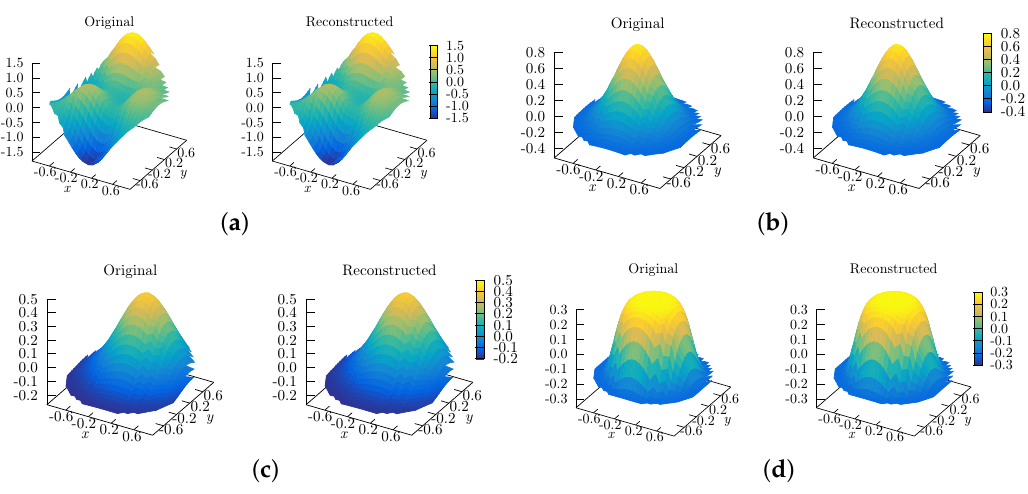
Figure 5. Qualitative reconstruction of several wavefronts, using Half Circular Harmonics, with J = 81. The functions depicted are: ( a ) the test function f 1 (see Equation (27), and Figure 4b for the top view); ( b ) a centered Gaussian (see Figure 4c); ( c ) an off-centered Gaussian (see Figure 4d); and ( d ) a centered super-Gaussian of order 6 (see Figure 4f).